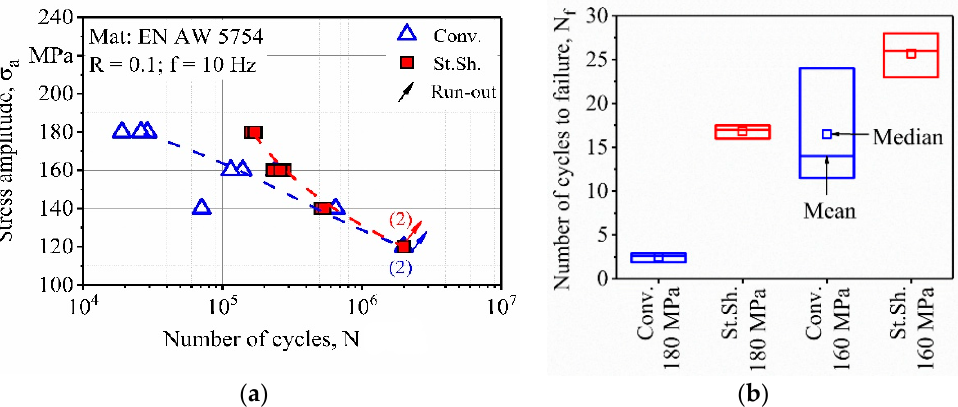
Figure 9. ( a ) Woehler curve for fatigue life assessment of friction-stir welding (FSW) specimens and ( b ) its statistical analysis.